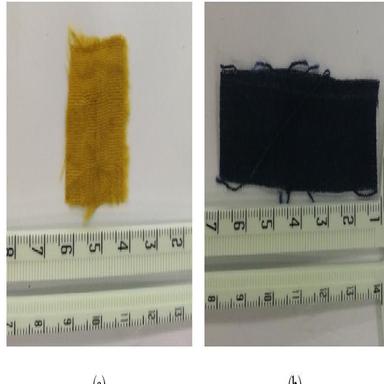
Historic textile samples used in this research, (a: historic1 (silk); b: historic2 (cotton)).